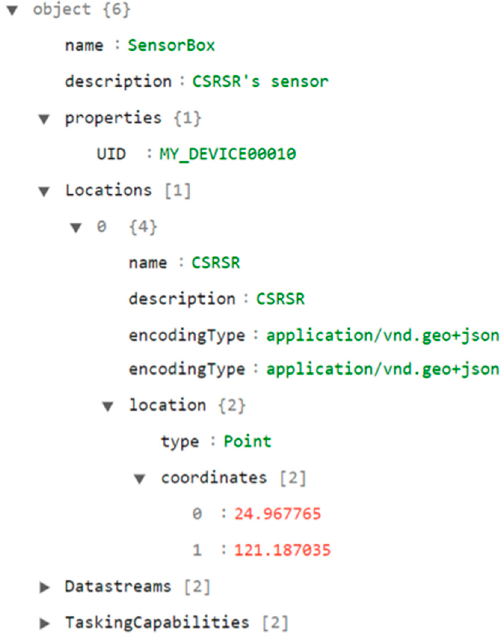
Figure 4. Thing metadata of an example description file.